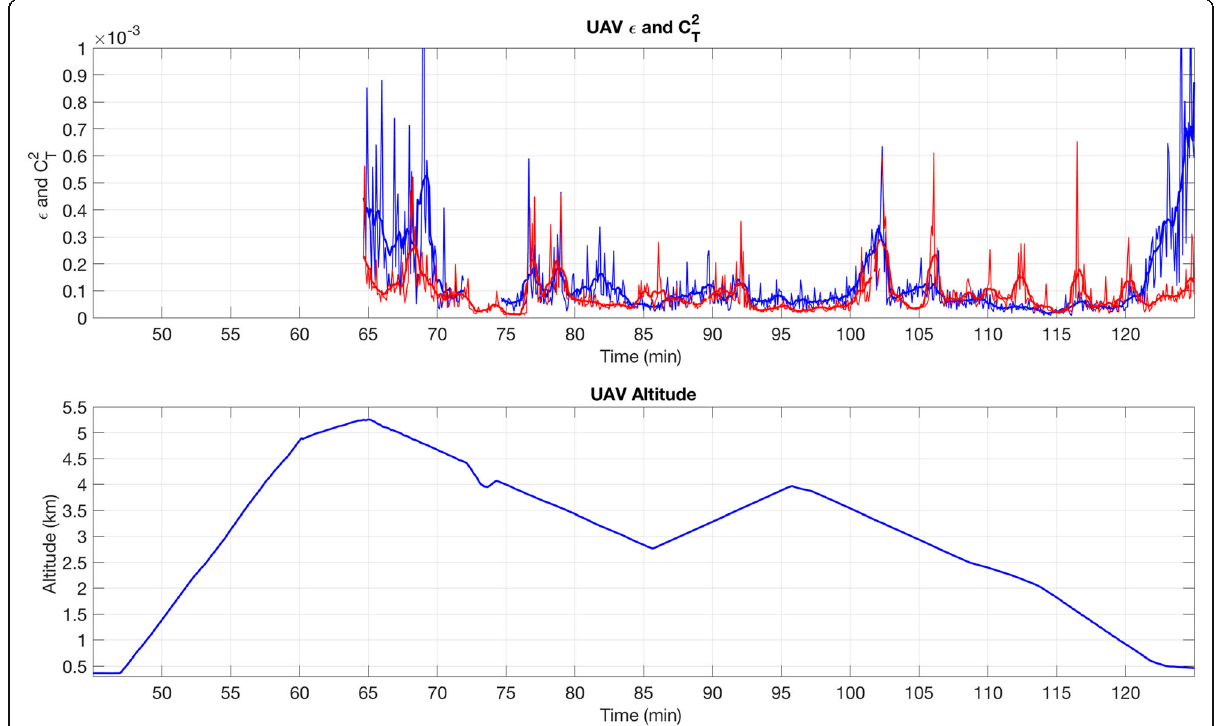
Fig. 15 ( Top panel ) UAV-measured ε UAV ( blue ) and C 2 (5 s interval) values, whereas thick lines show the 11-point (55 s) running mean values. C 2 ( Bottom panel ) UAV altitude as a function of